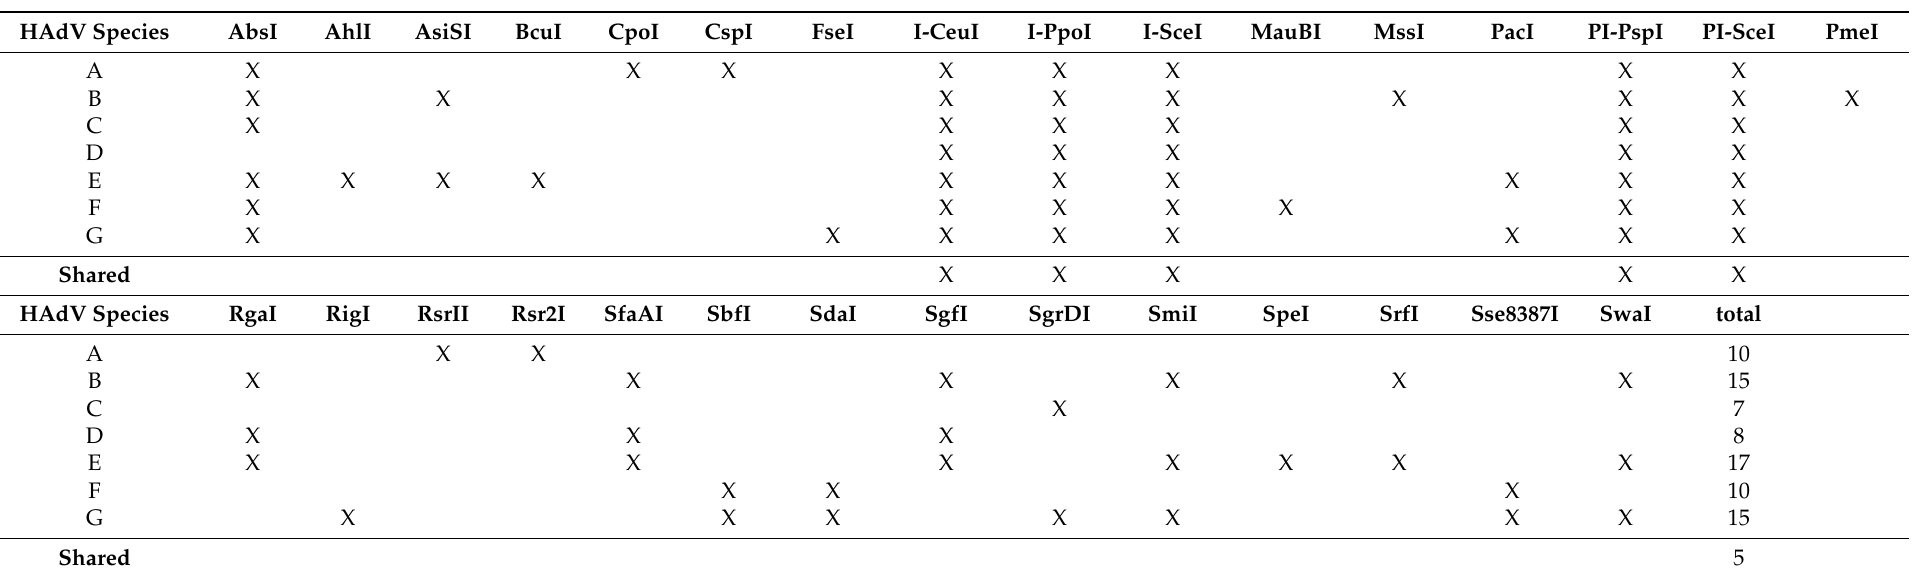
Table 1. Non-cutters scanning of human adenoviral